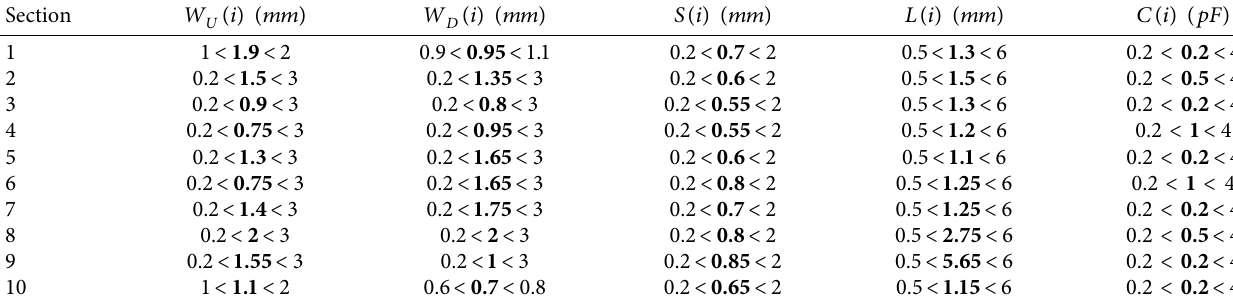
Table 5: Dimension and capacitor value for design 6dB ATRD coupler has been described in Example 2. Section